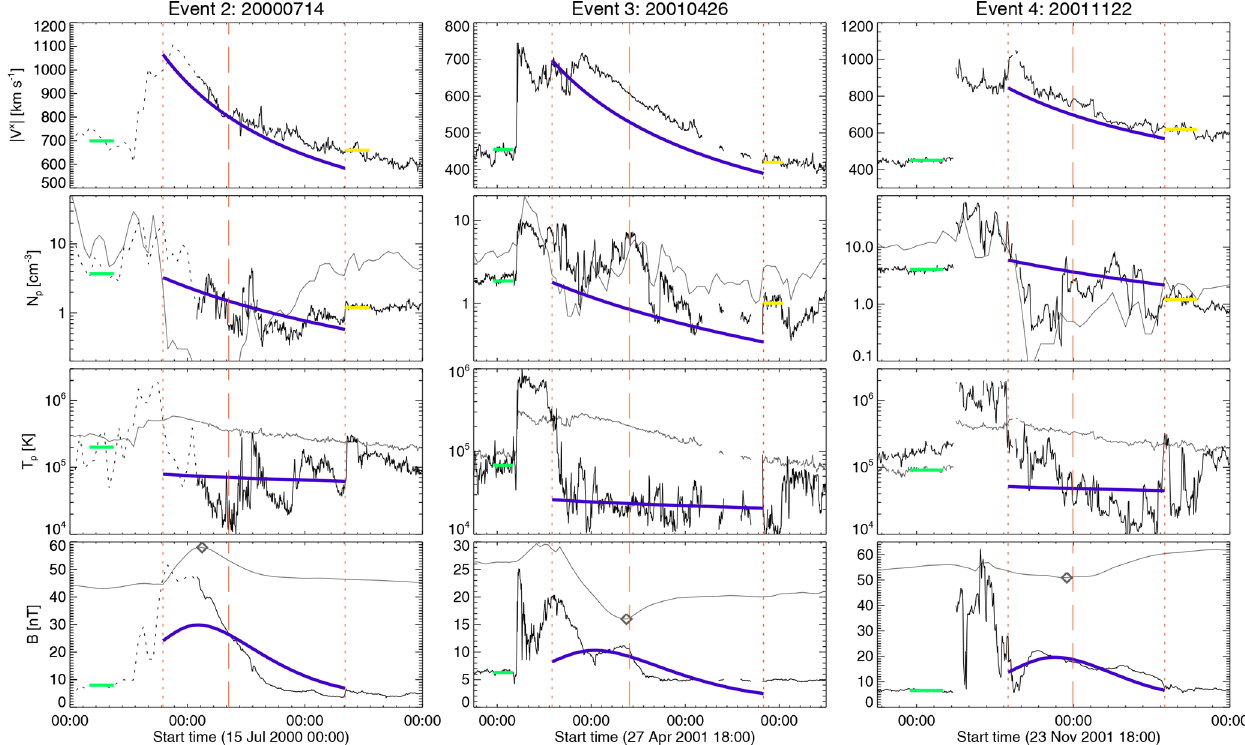
Figure 4. Calculated synthetic transit of Events 2, 3, and 4; each column shows a different event. From top to bottom, the panels present the radial component of the solar wind speed ( | V x | ), the density ( N p ) and temperature ( T p ) of protons and the magnetic field intensity ( B ). Solid blue lines are our model results. Short-dashed and long-dashed vertical red lines mark the CME boundaries and center, respectively. The solid (dotted) black lines are 5min (1h) in situ measurements as extracted from NASA/GSFC’s OMNI data set through the OMNIWeb service. Green solid lines mark in situ solar wind used for calculations (see Table 1). The solid grey lines in N p and T p panels are the plasma beta (10 folded) and the expected proton temperature ( T exp ) (Lopez, 1987; Richardson and Cane, 1993, 1995), respectively. The solid grey line in the B panel is the accumulative magnetic flux, as defined by Dasso et al. (2006), whose extremum (open diamond) gives an estimation for the magnetic center inside the